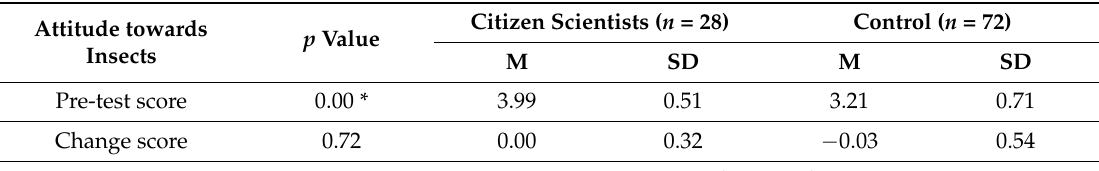
Table 8. Joint display of attitude towards insects mean (M) pre-test and change scores,